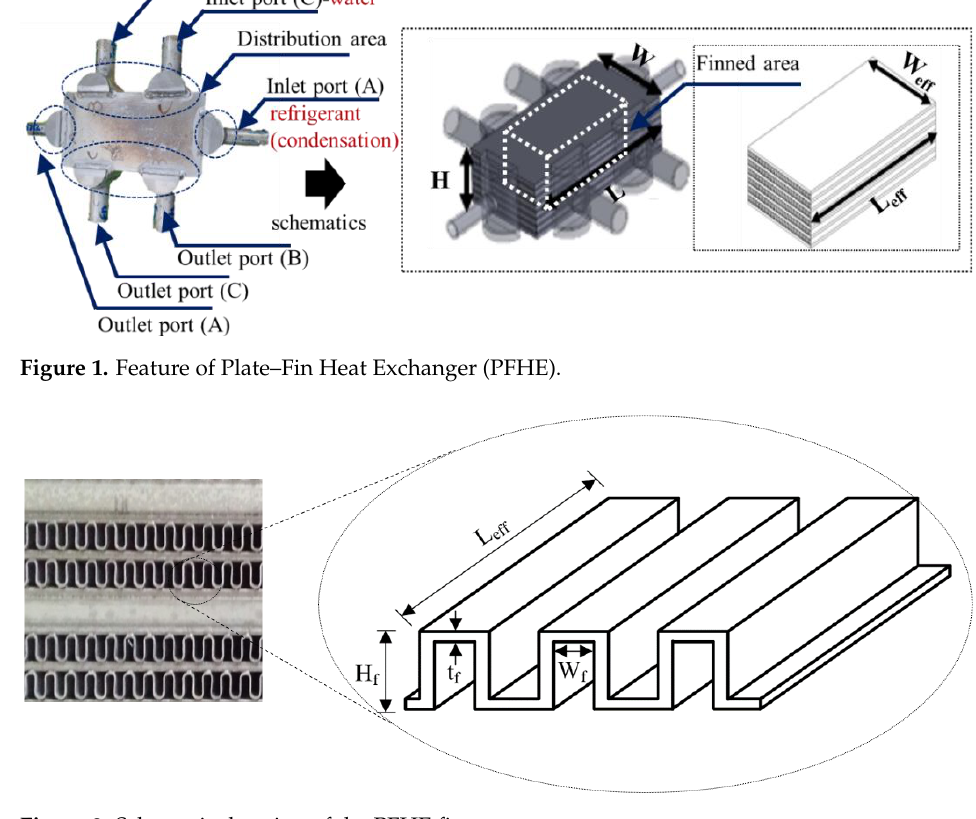
Figure 2. Schematic drawing of the PFHE fin.